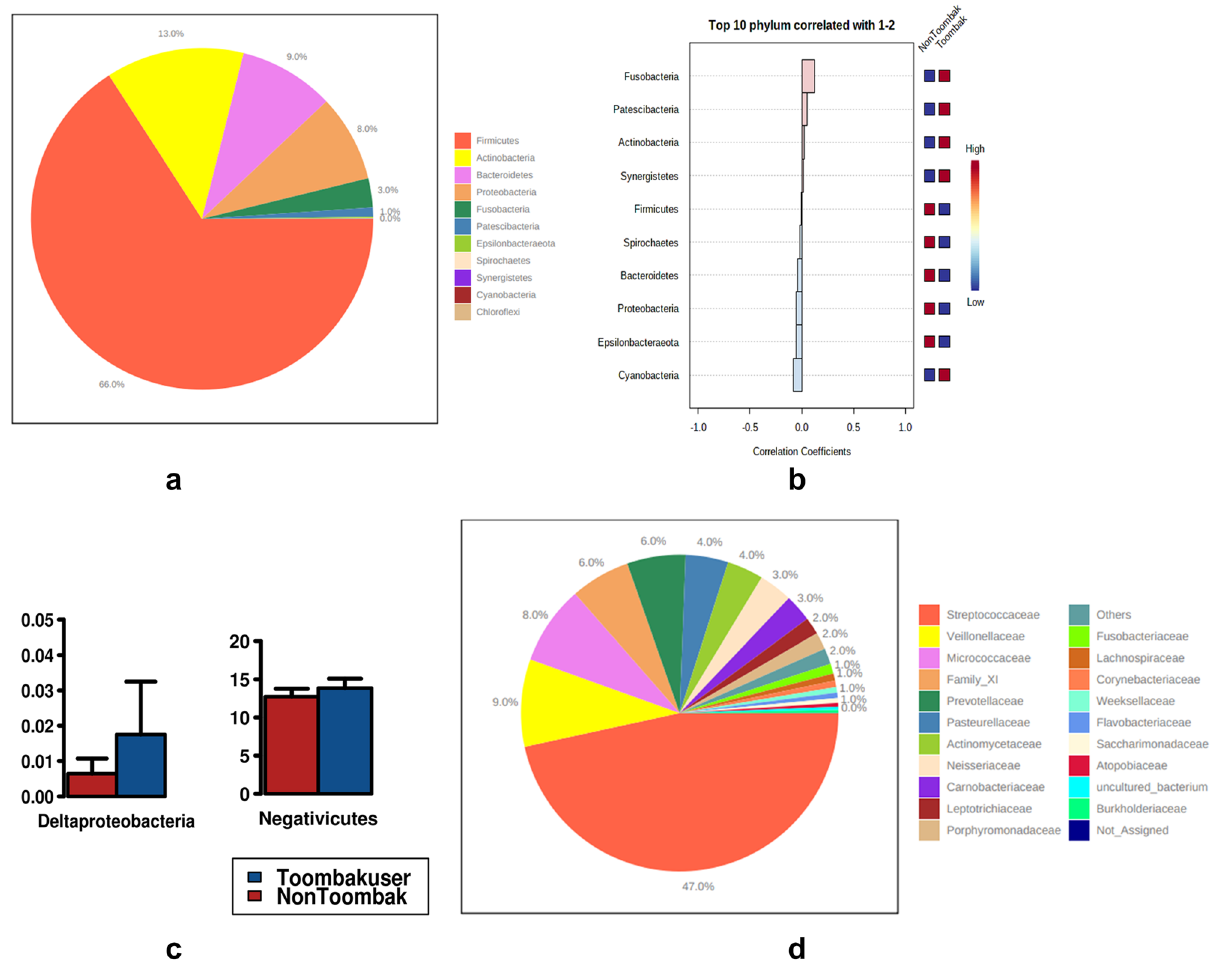
Figure 4. ( a ) Pie chart percentage composition of phyla from pooled saliva of both users and non-users of Toombak. Firmicutes (66%), Actinobacteria (13%), Bacteroidetes (9%), Proteobacteria (8%) and Fusobacteria (3%) are the most relatively abundant phyla. ( b ) Correlation plot of ten most abundant phyla in the Sudanese oral cavity of users and non-users of Toombak. Fusobacteria are the most correlated with Toombak use compared to Cyanobacteria in non-users. ( c ) Log-bar values of class composition of pooled saliva of both users and non-users of Toombak. Increased abundances in the classes Deltaproteobacteria and a slight increase in Negativicutes were found among Toombak users. ( d ) Pie chart percentage composition of families from pooled saliva of both users and non-users of Toombak. Streptococcaceae (47%), Veillonellaceae (9%)